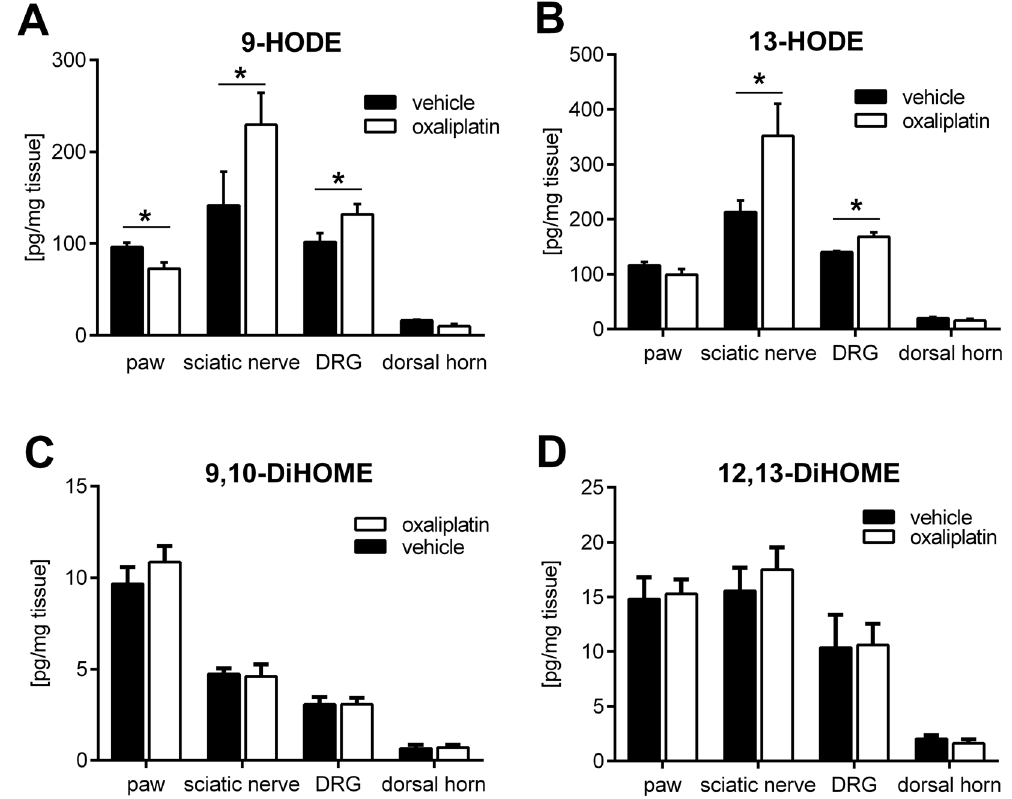
Figure 2. Increased oxidized lipid concentrations in sciatic nerve and DRGs after ten days’ treatment with oxaliplatin. Concentrations of 9-HODE ( A ), 13-HODE ( B ), 9,10-DiHOME ( C ) and 12,13-DiHOME ( D ) using LC-MS/MS measurements from plantar paw, sciatic nerve, DRGs and dorsal horn tissue of mice treated with vehicle (black bars; 0.9% v/v DMSO) or oxaliplatin (white bars; 3 mg/kg) ten days after injection. Data represent mean ± SEM from n = 5 mice per group; * p < 0.05 unpaired student’s